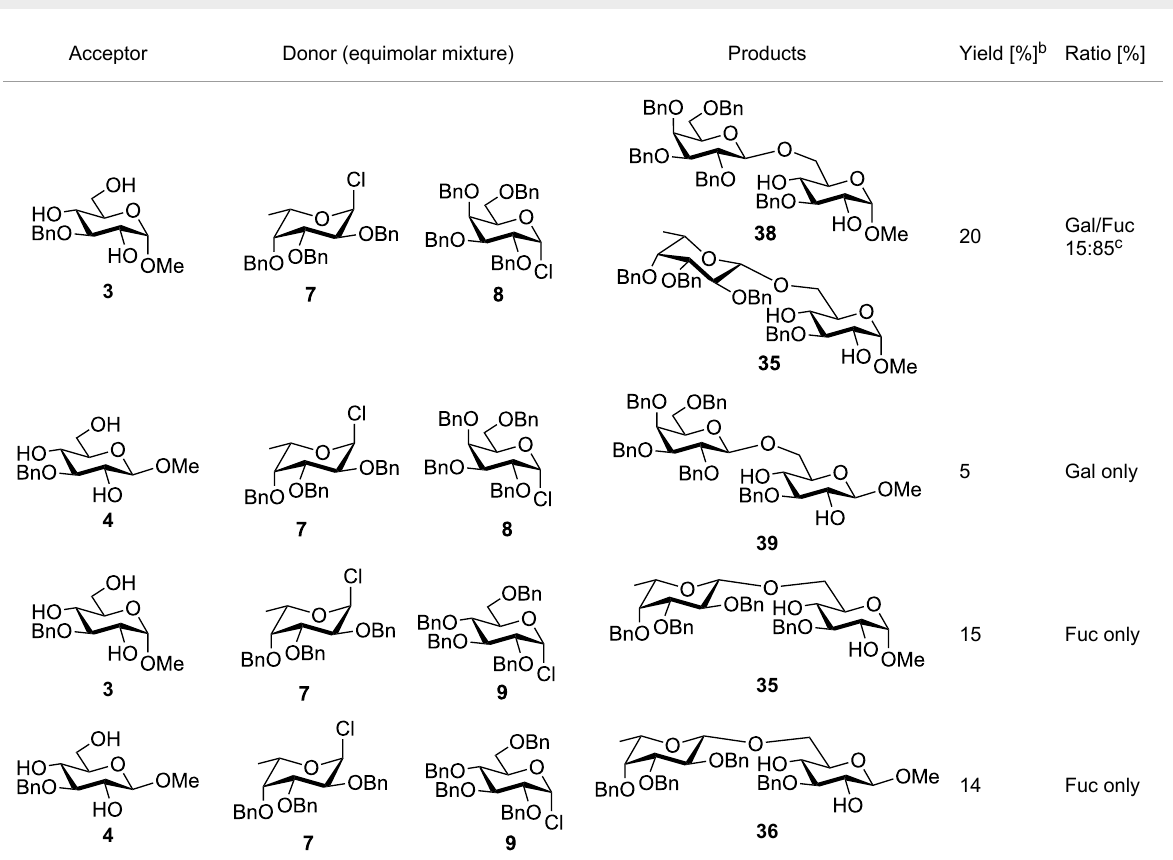
Table 2: Reactivity studies of acceptors 3 and 4 with donors 7 – 9 .